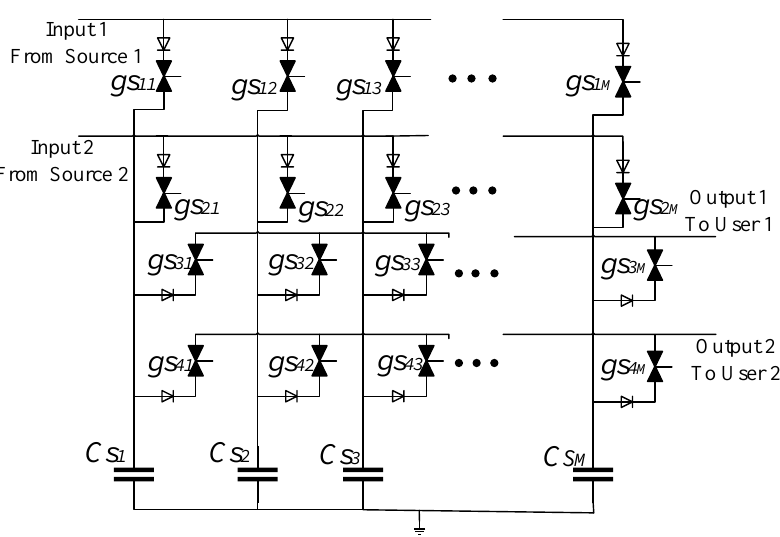
Figure 2. Schematic of an energy packet switch using supercapacitors as energy